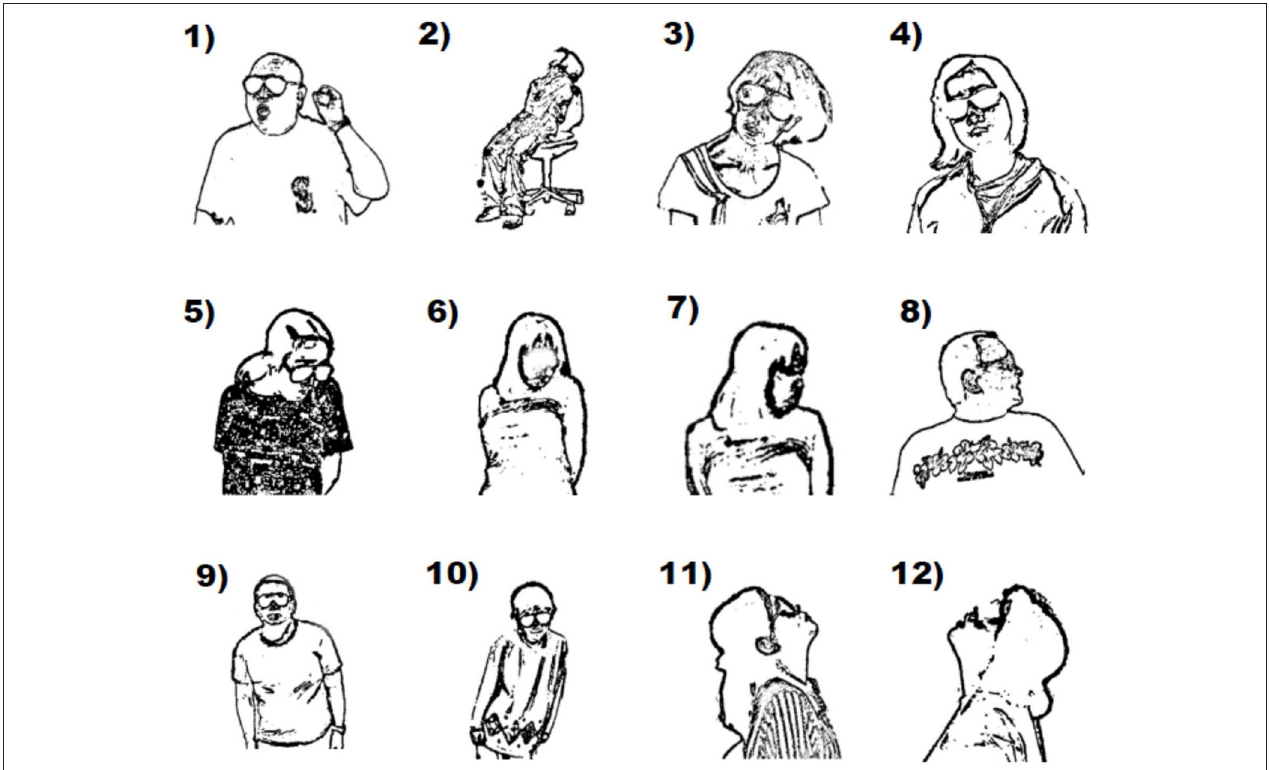
FIGURE 1 | Monochrome images of dystonic abnormal postures extracted from videoclips observed in schizophrenic patients receiving antipsychotics. (1) co-occurrence of cervical dystonia (mild torticollis) and catatonic posture (lifting a left arm); (2) trunk dystonia; (3,4) cervical dystonia (laterocollis); (5,6) cervical dystonia (mild torticollis with anterocollis); (7,8) cervical dystonia (severe torticollis); (9,10) Pisa syndrome; (11,12) cervical dystonia